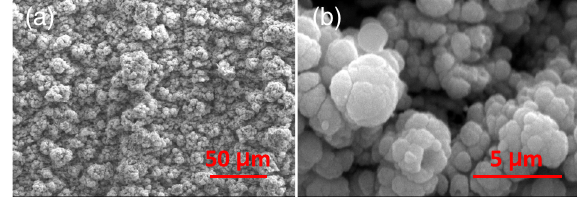
FIG. 2. (a) and (b): Scanning electron microscopy (SEM) micrographs, acquired with different magnifications, of the LASE sample under investigation [36].